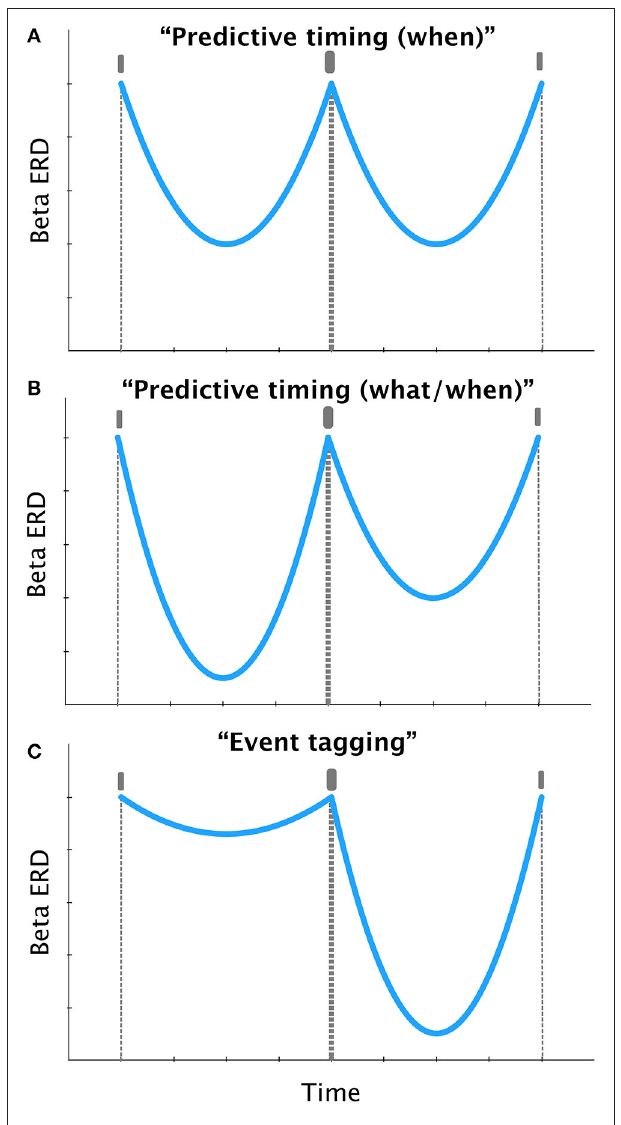
FIGURE 1 | Schematic depiction of the time course of induced beta oscillatory activity for a hypothetical sound sequence (indicated by vertical bars in gray, in the order, upbeat, downbeat, and upbeat), in accordance to the “predictive timing” and “event tagging” mechanisms. Presented pattern is based on previous studies such as Fujioka et al. (2012). (A) Predictive timing theory (e.g., Arnal and Giraud, 2012) suggests that beta power should peak before each sound, such that the rebound of beta power could be predictive of the timing of the upcoming sound, regardless of the salience of the sound. (B) A hypothesized predictive code that also encodes the identity of the salient events in a sequence may show modulation of the stereotypical beta ERD response in panel (A) , expressed in terms of differential magnitude (here, greater beta suppression) before the salient event. As opposed to panel (A) beta power is not modulated in the same manner before upbeats and downbeats, allowing the encoding of “what” and “when” information in a manner consistent with the predictive timing framework (e.g., Arnal and Giraud, 2012). (C) Event tagging proposal (Iversen et al., 2009; Hanslmayr and Staudigl, 2014) suggests that beta power encodes accented events and should peak after the accented sounds, which is in contradiction with the predictive coding of “what” information depicted in panel (B)